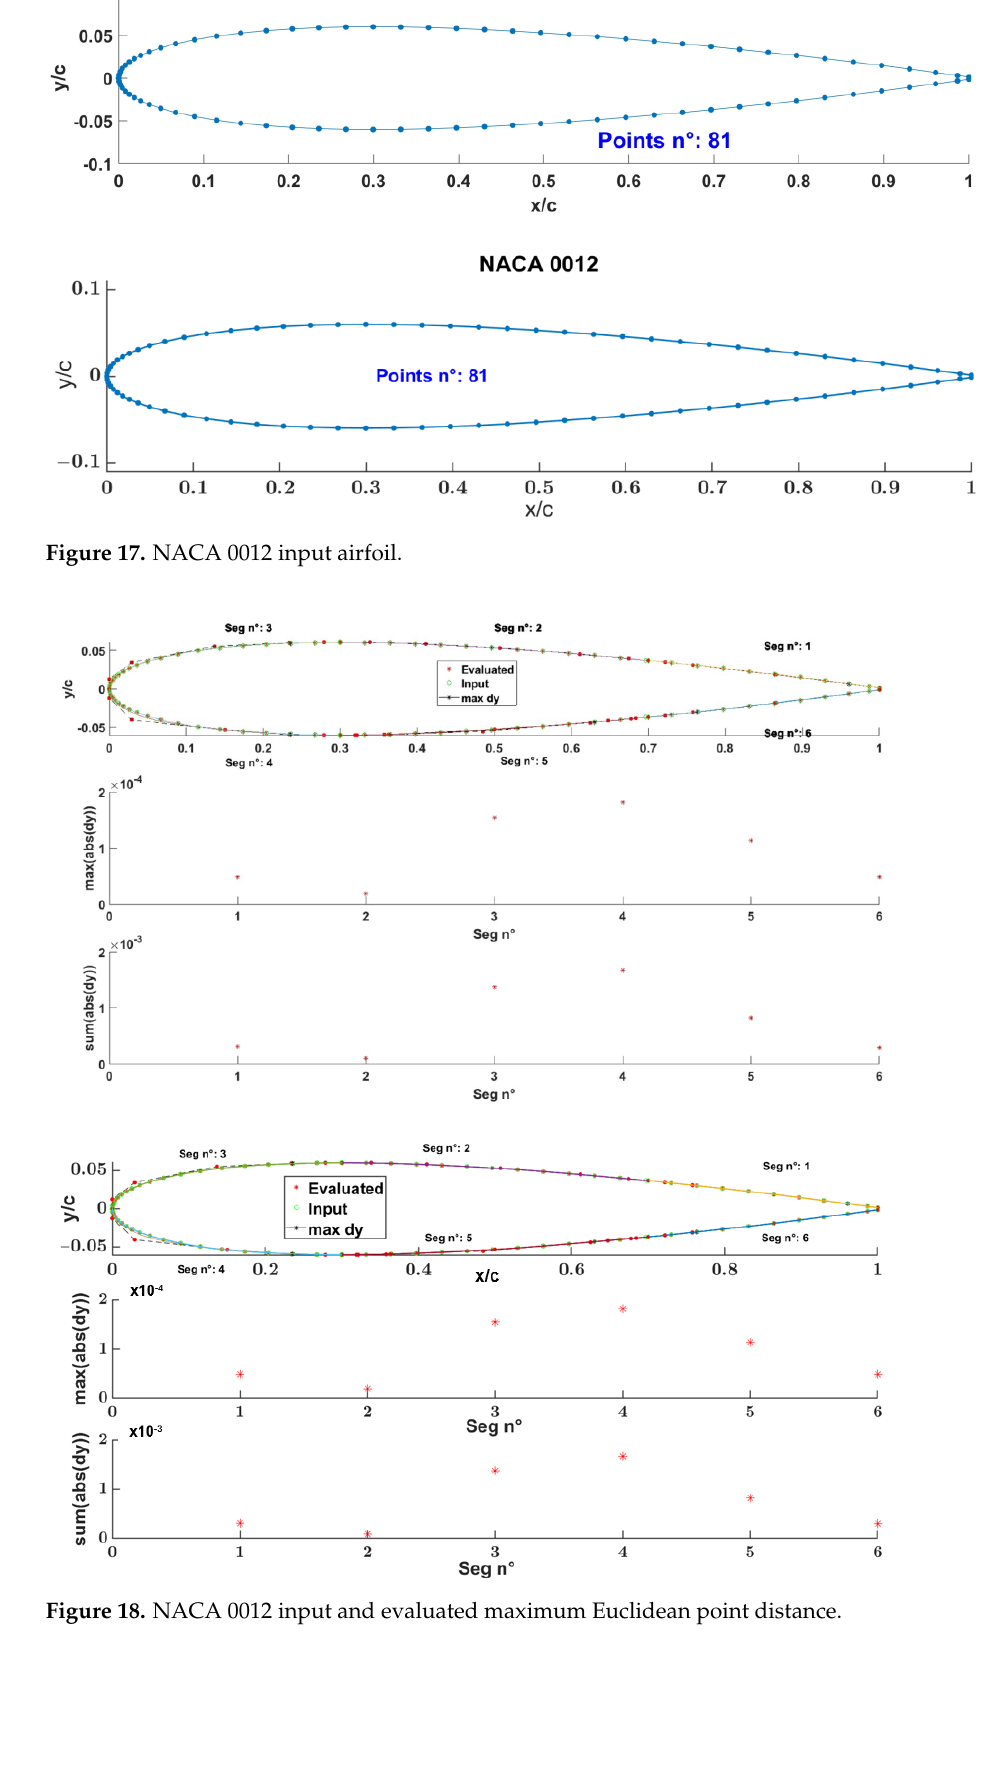
Figure 19 shows the comparison of the aerodynamic curves 𝑐 𝑙 (𝛼), 𝑐 𝑙 (𝑐 𝑑 ) 𝑐 𝑚 (𝑐 𝑙 ), 𝐸(𝛼) = 𝑐 𝑙 (𝛼) 𝑐 𝑑 (𝛼)⁄ between the target NACA 0012 and parametrized airfoil.